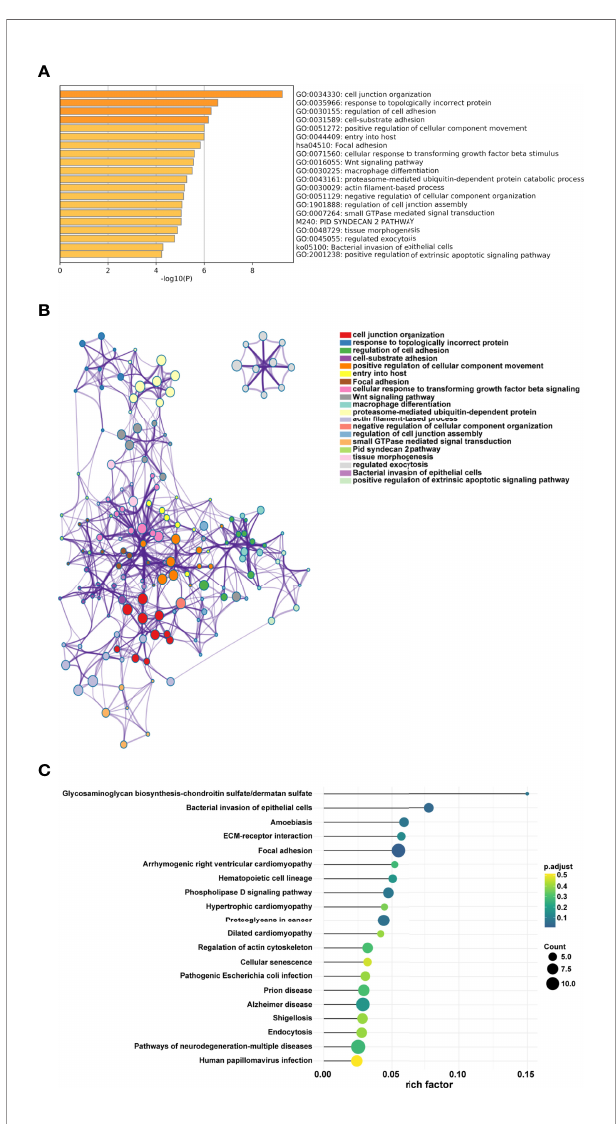
FIGURE 2 | Pathway function analysis. (A) Representative enriched terms of GO function. (B) The network colored by cluster ID of GO functions. (C) Representative enriched terms of KEGG